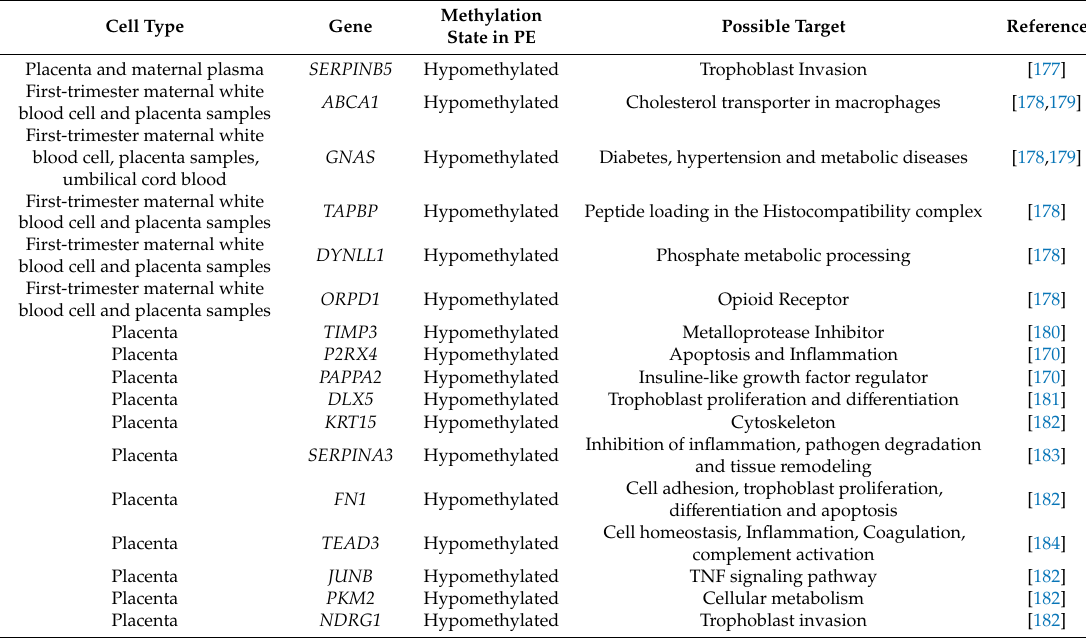
Table 3. Di ff erentially methylated genes in